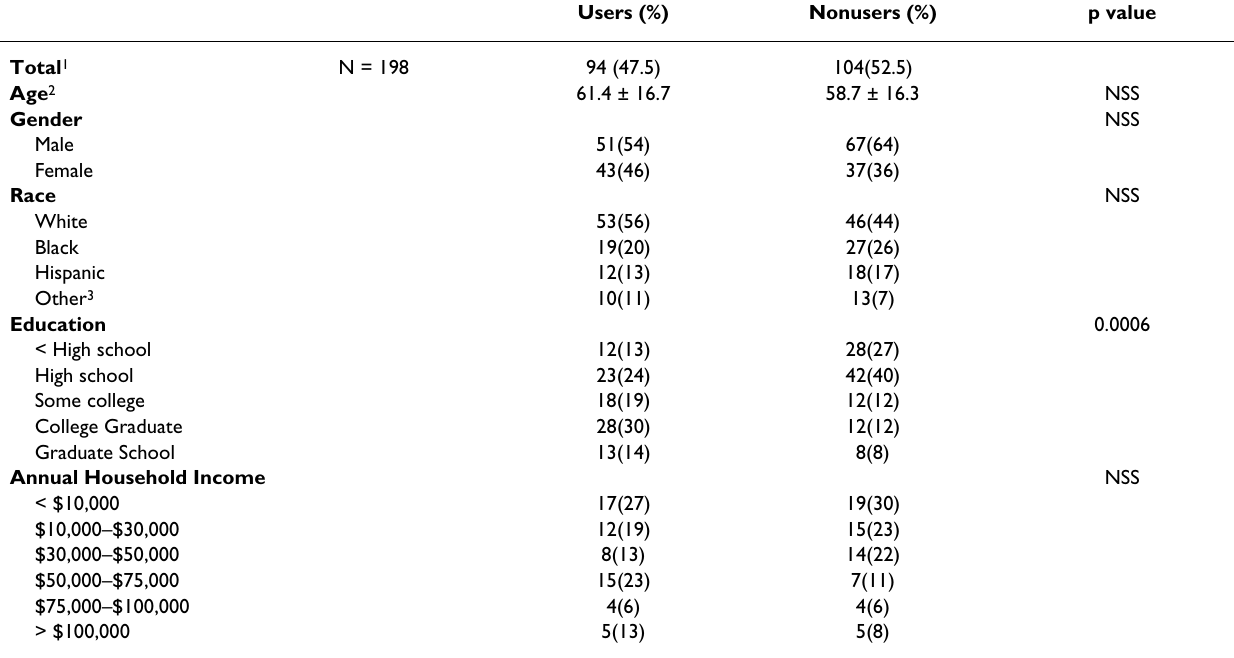
Table 1: Demographic Characteristics of Study